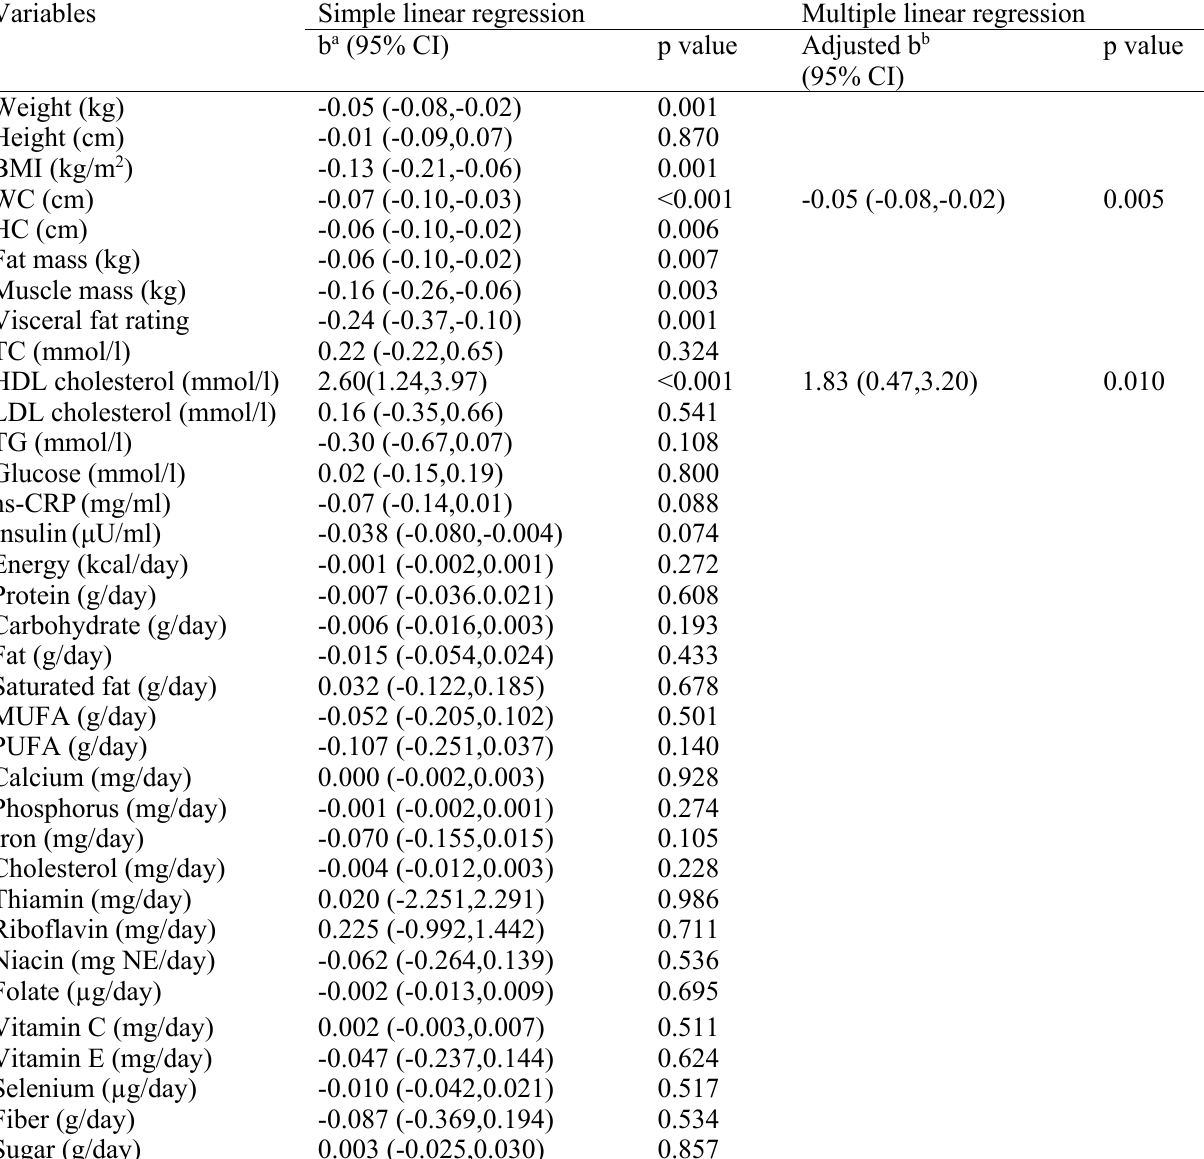
Table 2 Associations of nutritional status with HMW adiponectin among breast cancer cases Variables Simple linear regression Multiple linear